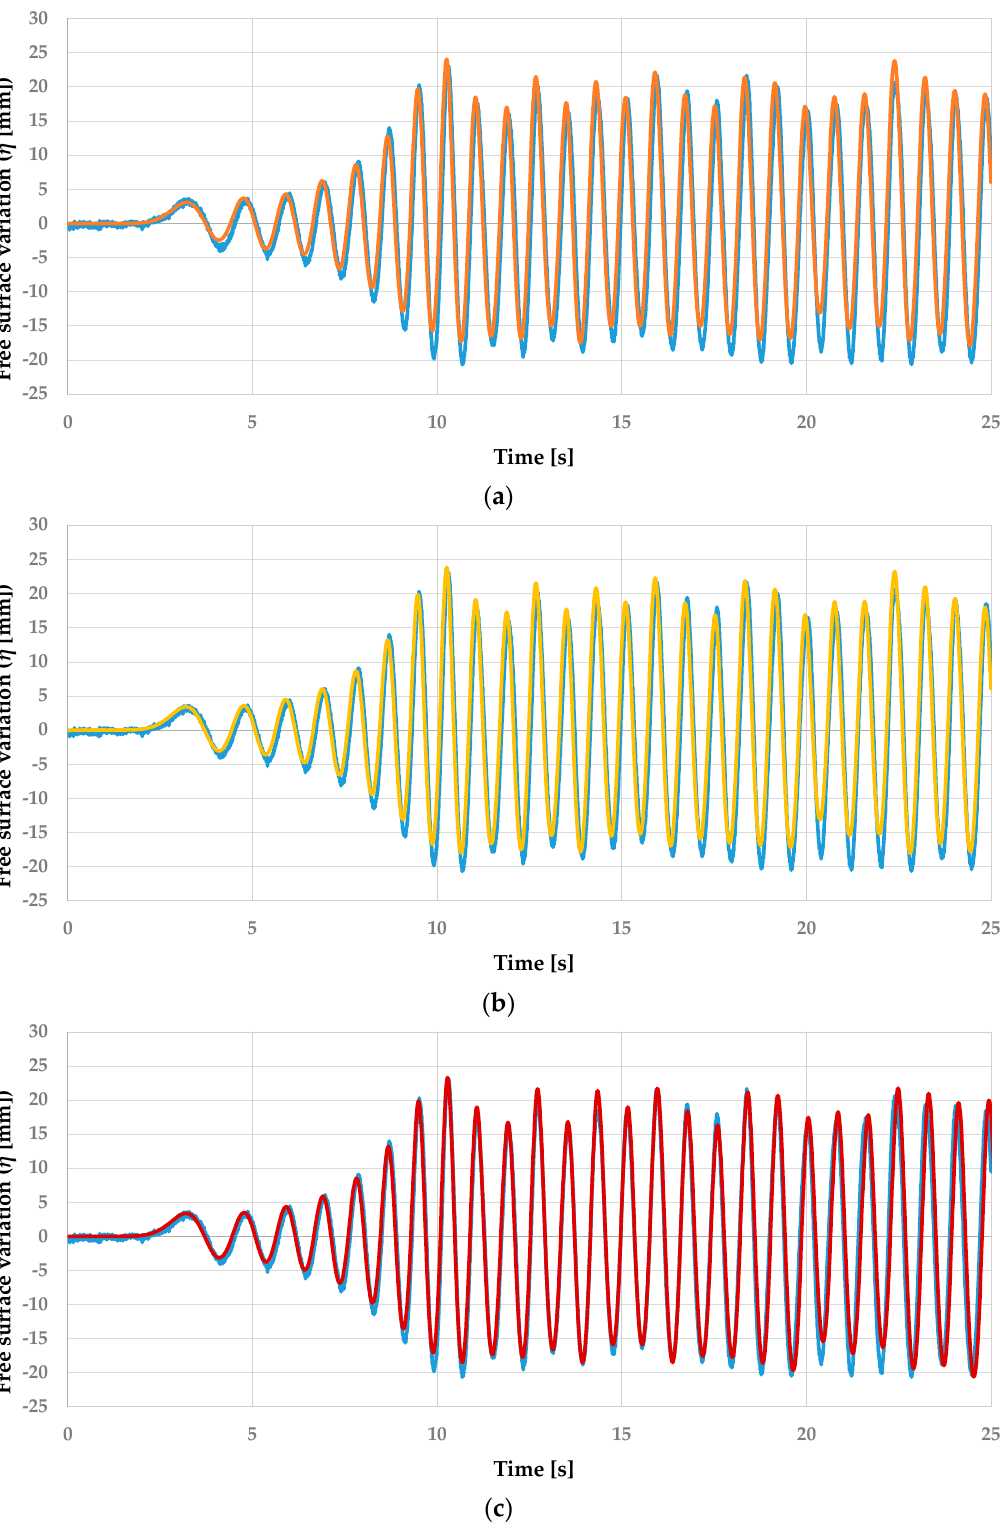
Figure 5. Comparison of the free surface displacement for the turbulence model of ( a ) k- ε , ( b ) SST, and ( c ) LES with the experimental data (blue) obtained in the EWF for the wave 3.